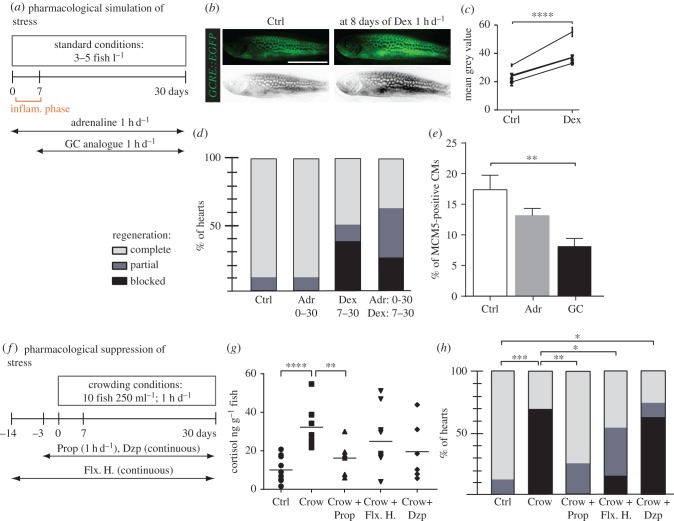
Pharmacological simulation of stress reproduces the crowding phenotype, which can be partially rescued by treatment with propranolol and fluoxetine hydrochloride. (a,f) Experimental design. (b) Live Tg(GCRE::EGFP) fish imaged for fluorescence (green converted to grey) before (Ctrl) and after 8 days of 2 mg l−1 dexamethasone (Dex) treatment for 1 h d−1 validates the activity of the drug. (c) Quantification of grey-converted fluorescence shown in (b); N = 4. (d,h) Regenerative scores of AFOG stained hearts at 30 dpci; N ≥ 8. (e) Quantification of MCM5 and DsRed-positive nuclei at 7 dpci in control and after treatments; N ≥ 6. (g) Measurements of whole-body cortisol after single stress exposure in fish with different pretreatment; N ≥ 5. Drugs: glucocorticoid (GC), dexamethasone (Dex, 2 mg l−1, 1 h d−1), adrenaline (Adr, 1 mg l−1, 1 h d−1), hydrocortisone (1 mg l−1), propranolol (Prop, 1 mg l−1, 1 h d−1), fluoxetine hydrochloride (Flx. H., 100 µg l−1, continuous), diazepam (Dzp, 1 mg l−1, continuous treatment). *p < 0.05, **p < 0.01, ***p < 0.001, ****p < 0.0001. (b) Scale bar, 10 mm.